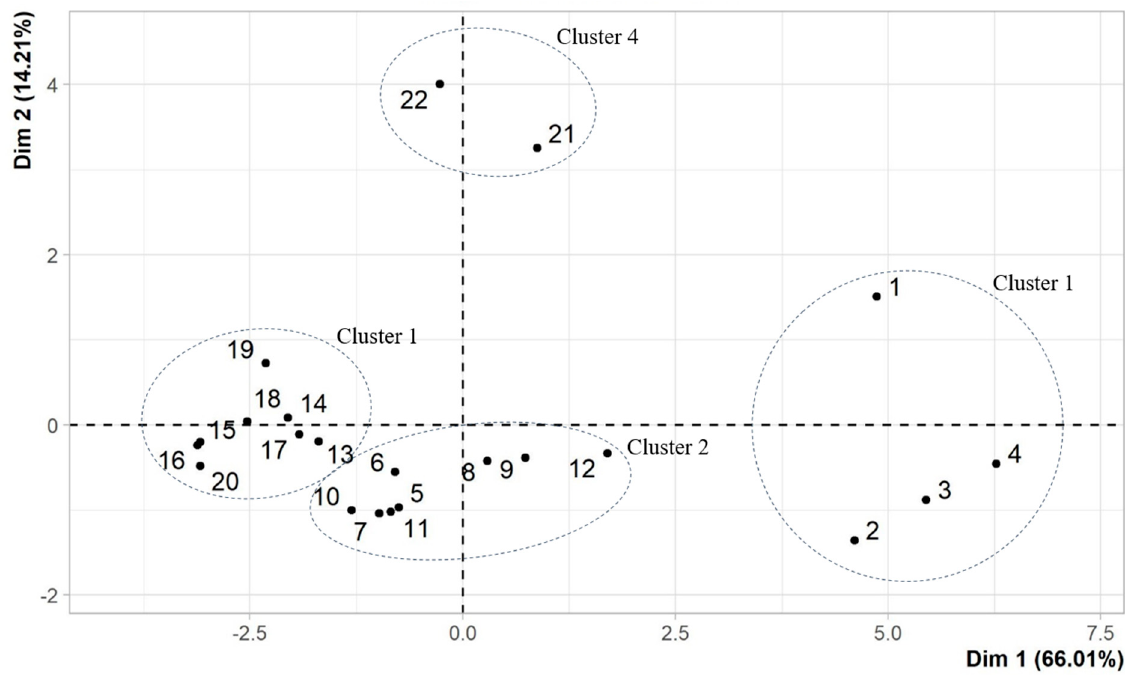
Figure 5. Identification of four clusters by HCA obtained from the PCA individuals (numbers correspond to the ID number given for all growing media constituents listed in Table 1).